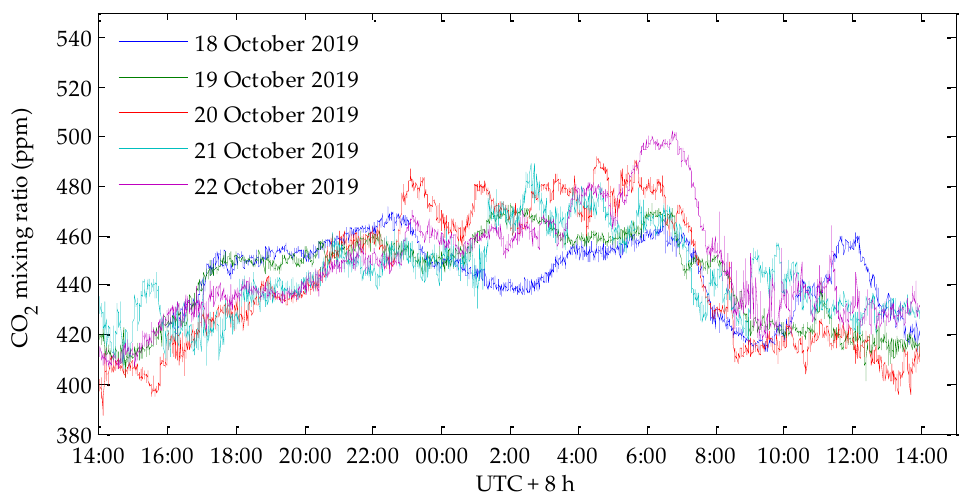
Figure 22. The measurement results of the IPDA lidar over five consecutive days in autumn